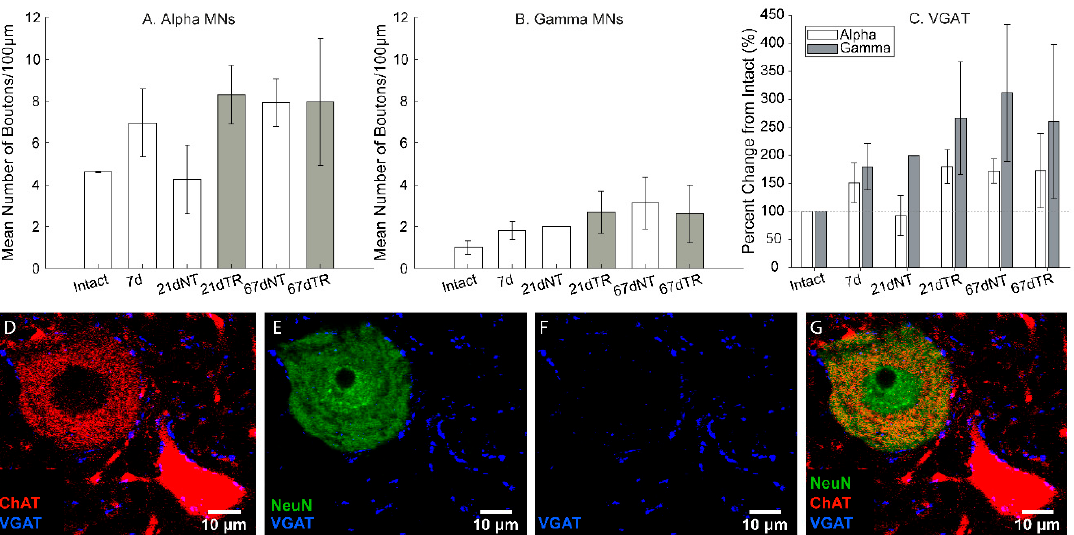
Figure 4. Intraspinal GABAergic / glycinergic boutons were detected with the antibody against VGAT. No significant di ff erences in the absolute number of VGAT boutons were observed in α -MNs ( A ) or γ -MNs ( B ). In ( C ), the percent change of VGAT boutons showed no significant di ff erences between α - and γ -MNs. Motoneurons were identified as ChAT + (red) cells in the ventral horn. ( D ) NeuN (green) is only expressed in α -motoneurons and other interneurons. ( E ). VGAT boutons (blue) were identified in close apposition to both γ - and α -motoneurons. ( F ). ( G ) Combined triple filters .